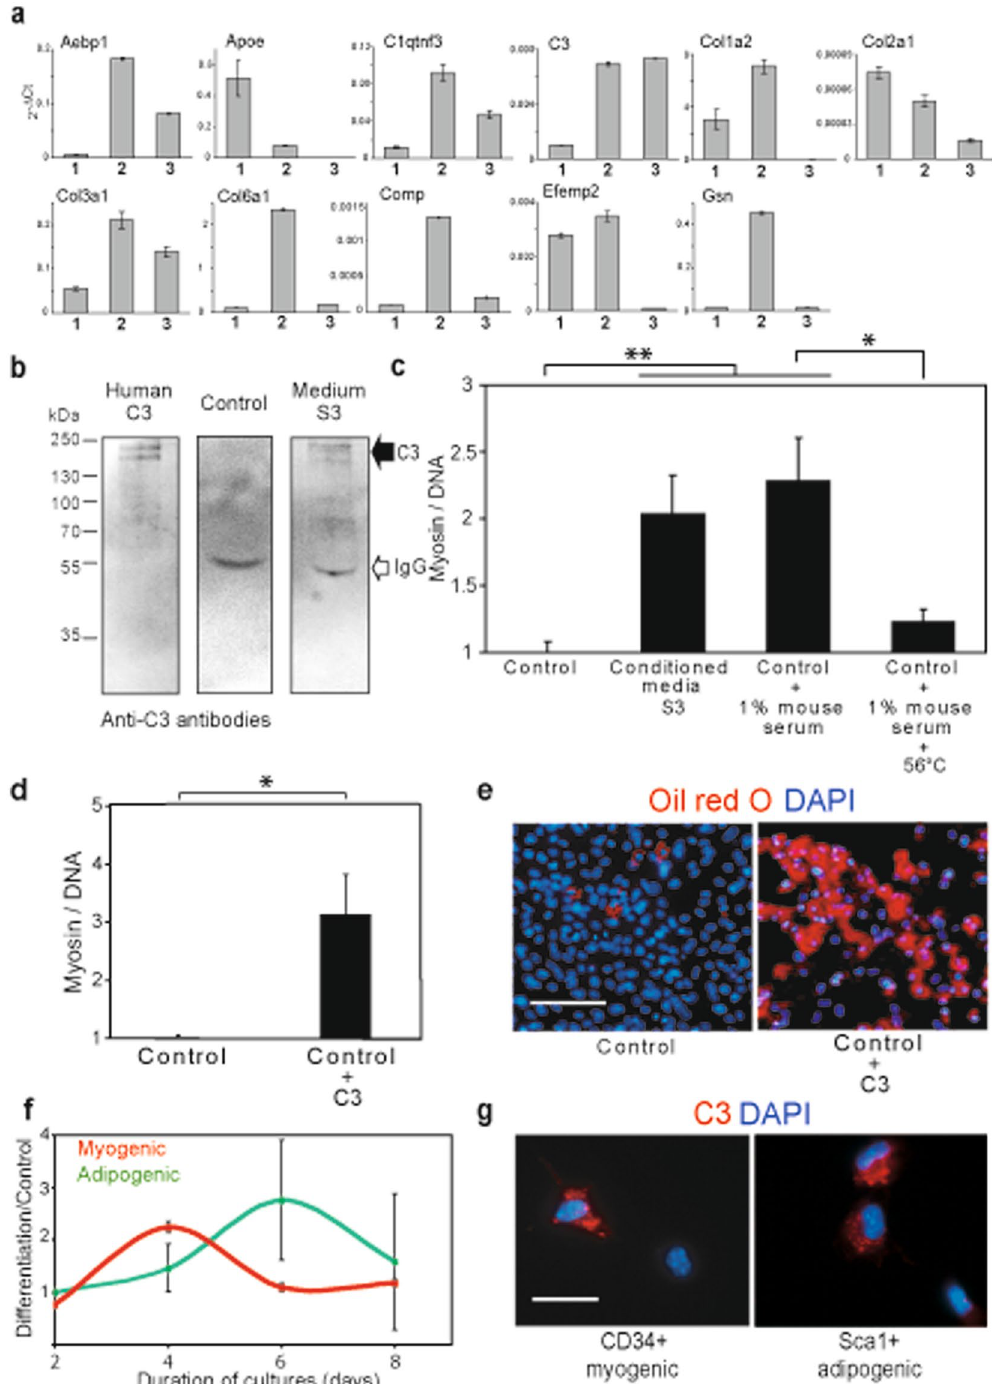
Figure 4. Complement C3 promotes cell differentiation of myogenic lineage cells and adipogenic lineage cells. ( a ) Expression of the putative myogenic factors in distinct cell cultures. The expression of the putative myogenic candidates identified from the omics analyses was analysed by q-RT-PCR. Three distinct cultures were examined, initial fraction cells (1), CD34 + /Sca1 + primary cells (used in omics analyses and efficient for myogenic differentiation) (2), and CD34 + /Sca1 + cells after three passages (highly efficient for myogenic differentiation, S3 in Fig. 2c) (3). The data are expressed relative to Gapdh transcription (2 −Δ Ct ). ( b ) Complement C3 is present in conditioned media. Purified human C3, control media (DMEM/decomplemented FCS) and conditioned media S3 (see Fig. 2c) were resolved in SDS-PAGE and analyzed by western blotting with anti-C3 antibodies. ( c ) Growth media supplemented with serum (active complement) promoted myogenic differentiation. Initial fraction cells were cultured in DMEM/decomplemented FCS (Control), myogenic conditioned media S3 (Conditioned media S3), DMEM/decomplemented FCS supplemented with 1% mouse serum (Control + 1% mouse serum) and DMEM/decomplemented FCS supplemented with 1% mouse